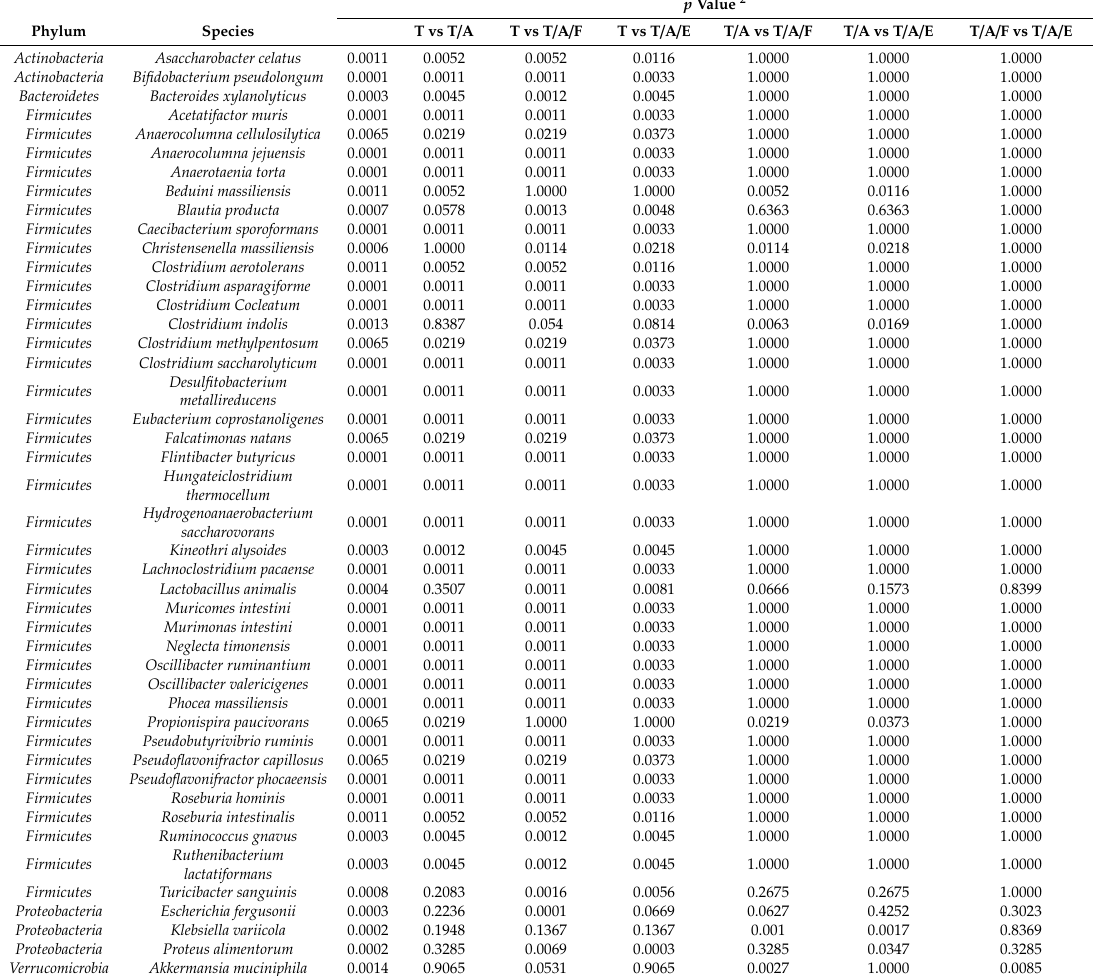
Table 1. Bacterial species with significantly varied abundance between C57BL / 6 groups based on treatment 1 .